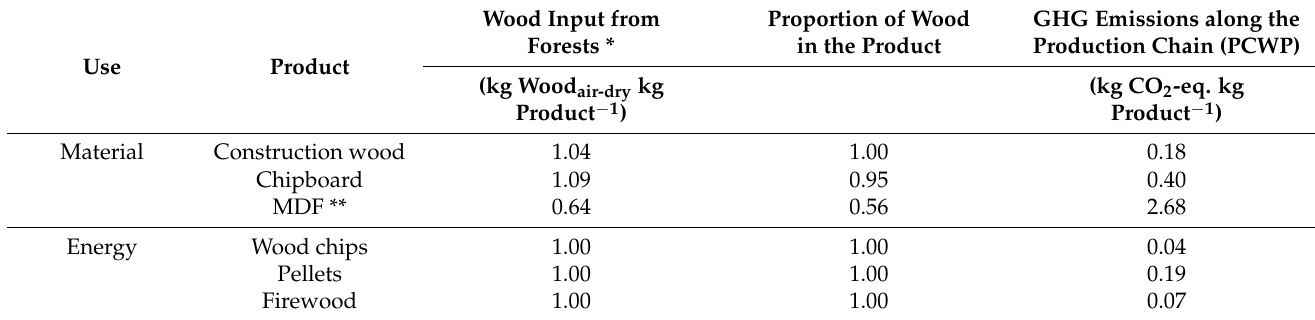
Table 1. GHG emissions along the production chain of wood products (PCWP).